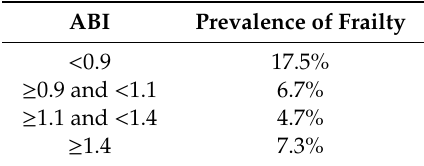
Table 2. Prevalence of Frailty depending on the ABI value